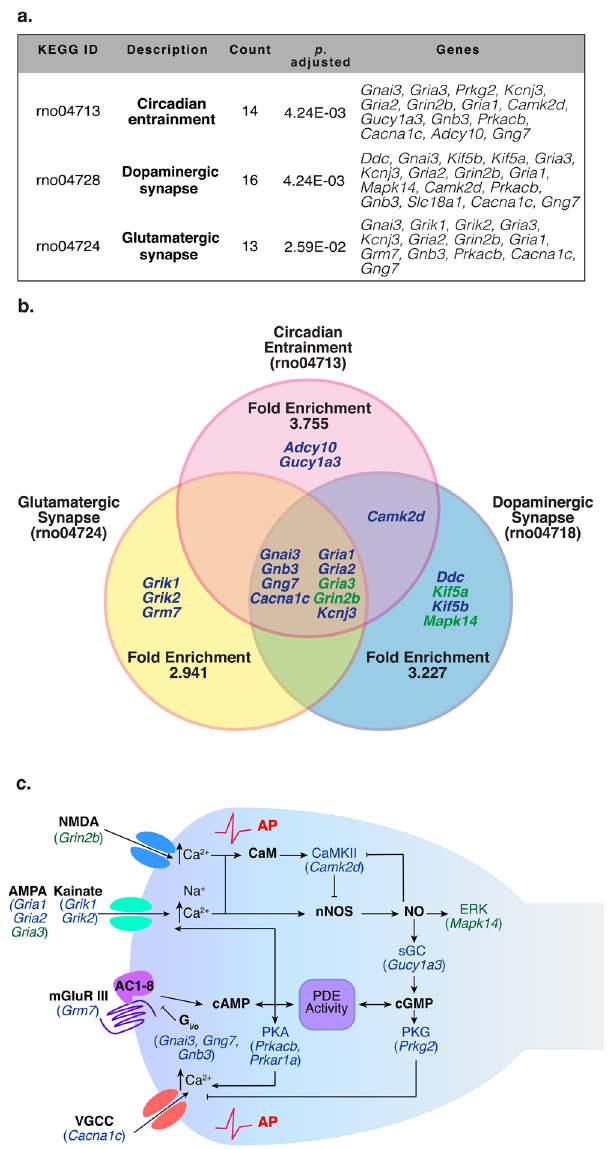
Figure 6. KEGG Enrichment Pathways in SHR versus Wistar Stellate Ganglion. We identified 3 KEGG functional enrichment pathways that are particularly relevant to post-synaptic postganglionic signalling ( a ). The highest over-represented group was ‘Circadian Entrainment’ (rno04713; p . adj = 4.24 × 10 − 3 ) followed by ‘Dopaminergic Synapse’ (rno04728; p . adj = 4.24 × 10 − 3 ) and ‘Glutamatergic Synapse’ (rno04724; p . adj = 2.59 × 10 − 2 ). The Venn Diagram depicts the upregulated genes (green) and downregulated genes (blue) and highlights the overlap between each of the respective over-represented KEGG groups ( b ). Other over- represented KEGG groups are included in the supplementary data. In ( c ), we show an integrated KEGG enrichment diagram, combining signalling pathways from the over-represented KEGG pathways ‘Circadian entrainment’, ‘Dopaminergic synapse’ and ‘Glutamatergic synapse’. Here we highlight the possible involvement of these transcriptomic changes on intracellular signalling. This figure is primarily based on the supplied rno04713 KEGG